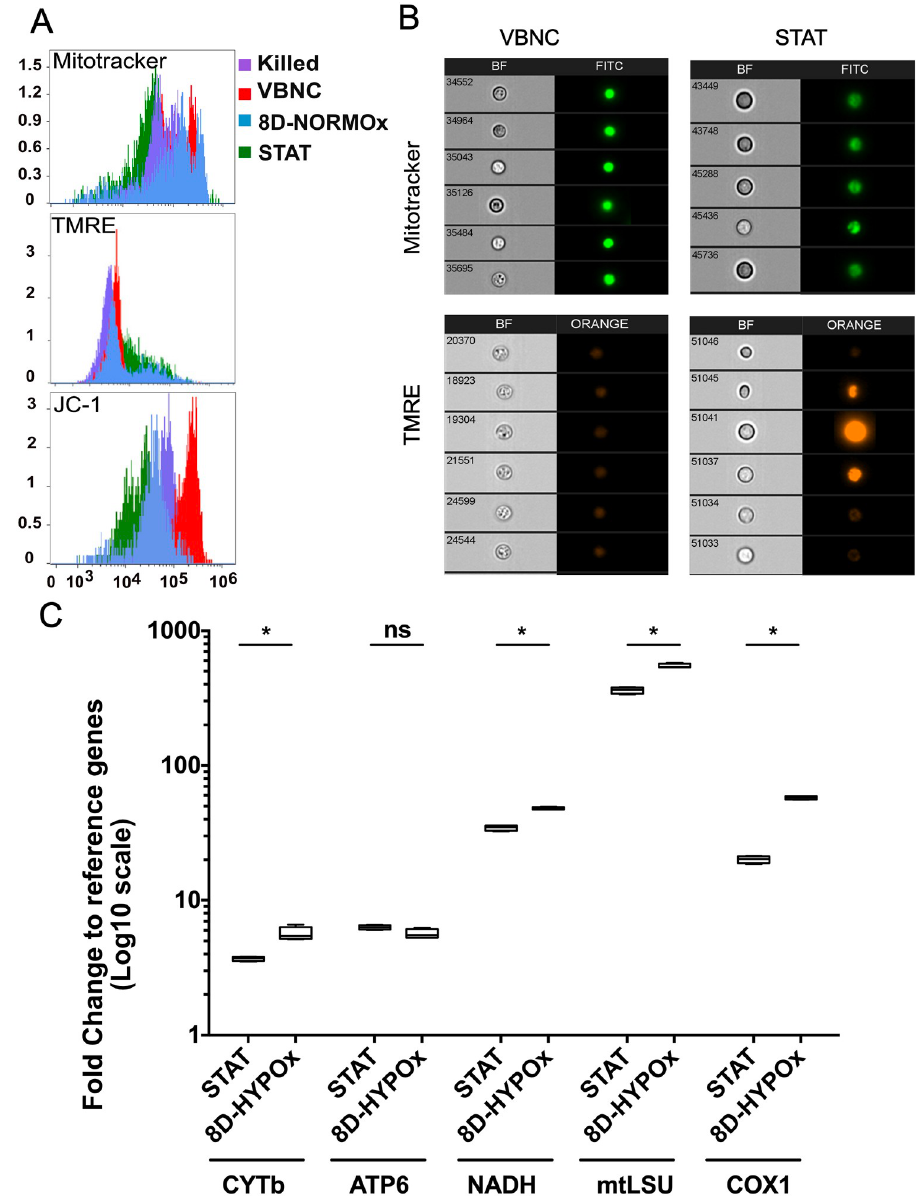
Fig 5. Mitochondria of VBNC were depolarized with an increased mass and gene expression. A . Mitochondria mass, and polarization were assessed in VBNC, 8D-NORMOx, STAT and heat killed yeasts using Mitotracker green and TMRE and JC-1 stainings, respectively and the ImageStream technology. In VBNC (red histogram), the Mitotracker staining is high, TMRE low and JC-1 high compared to STAT (blue histogram). Representative of two independent experiments. B . Microscopic visualization with Imagestream of the Mitotracker and TMRE stainings in VBNC and STAT yeasts, showing the contrast in the intensity of the stainings between conditions. Representative of two independent experiments. C . Expression of five mitochondrial genes, cytochrome B (CYTb), ATP synthase 6 (ATP6), NADH deshydrogenase (NADH), mitochondrial large sub unit (mtLSU), and cytochrome oxidase (COX1) as expressed as the fold change to the geometric mean of the expression of GAPDH and ACT1 housekeeping genes. The expression of CYTb, NADH, mtLSU and COX1 is significantly increased in VBNC compared to STAT ( � p = 0.029). Two technical and 2 biological replicates are represented